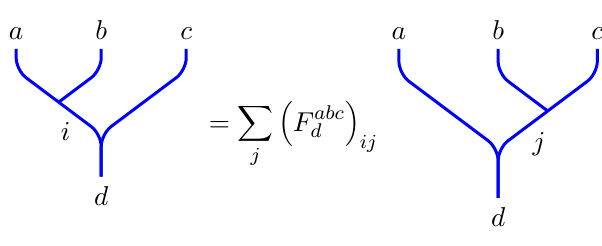
Figure 1 . Definition of the F -matrix as a basis change in fusion space. Graphically, this corresponds to sliding the b line from a to c